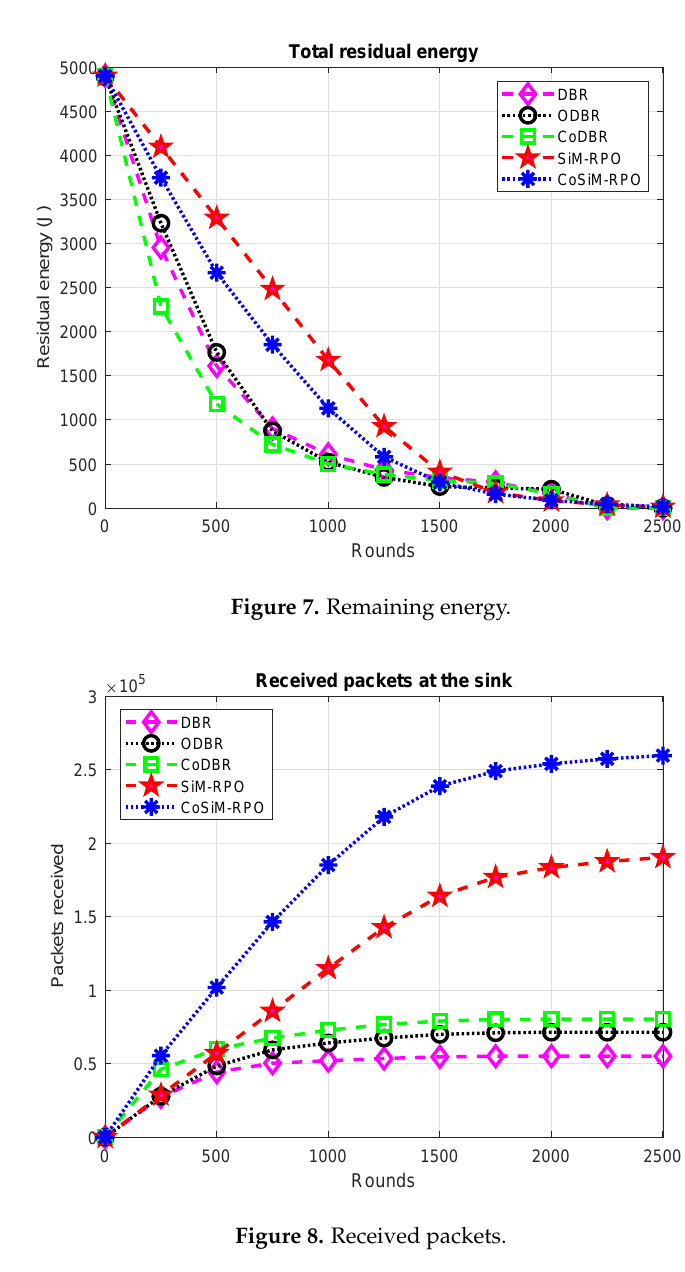
Figure 8. Received